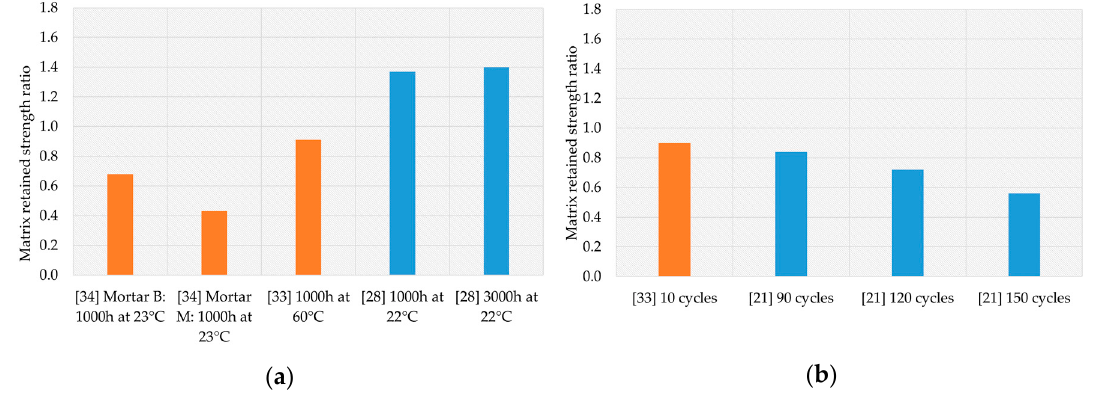
Figure 3. Effect of saline environments on the matrix tensile strength: ( a ) continuous immersion and ( b ) wet–dry cycles (blue bin = cement-based matrix and orange bin = lime-based matrix).